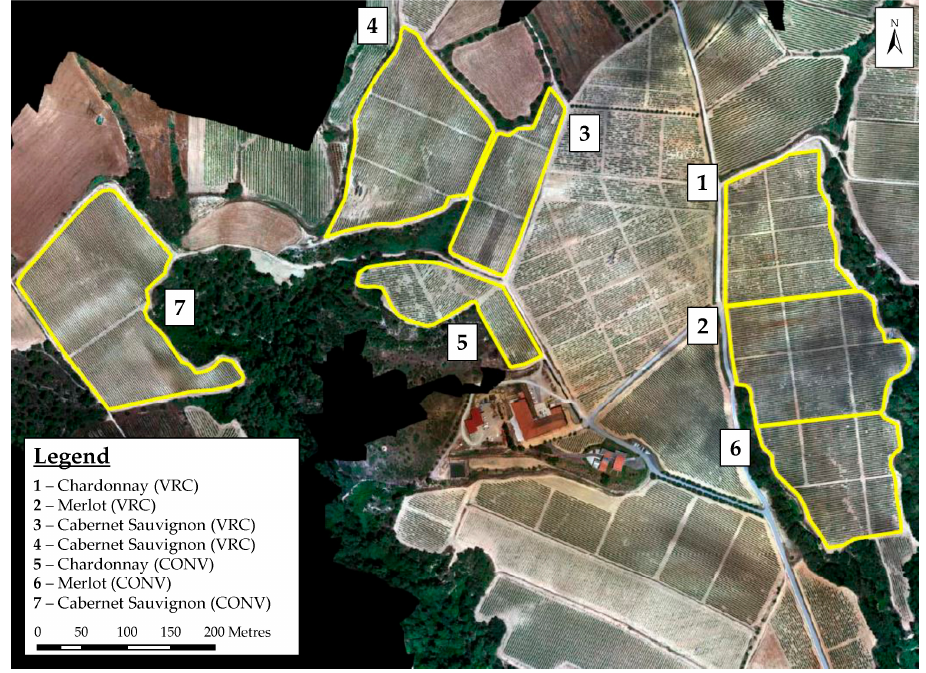
Figure 2. Orthophoto map of the experimental vineyard parcels.